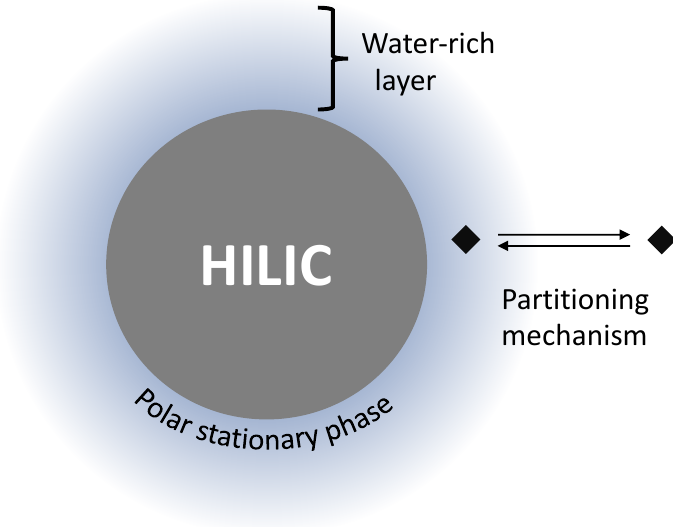
Figure 3. Scheme of the mechanism regulating elution in HILIC. The polar stationary phase is surrounded by a layer rich in water, whereas the mobile phase is an organic solvent. Probably, the analytes are retained because of partitioning mechanism. It results that more hydrophilic components are more